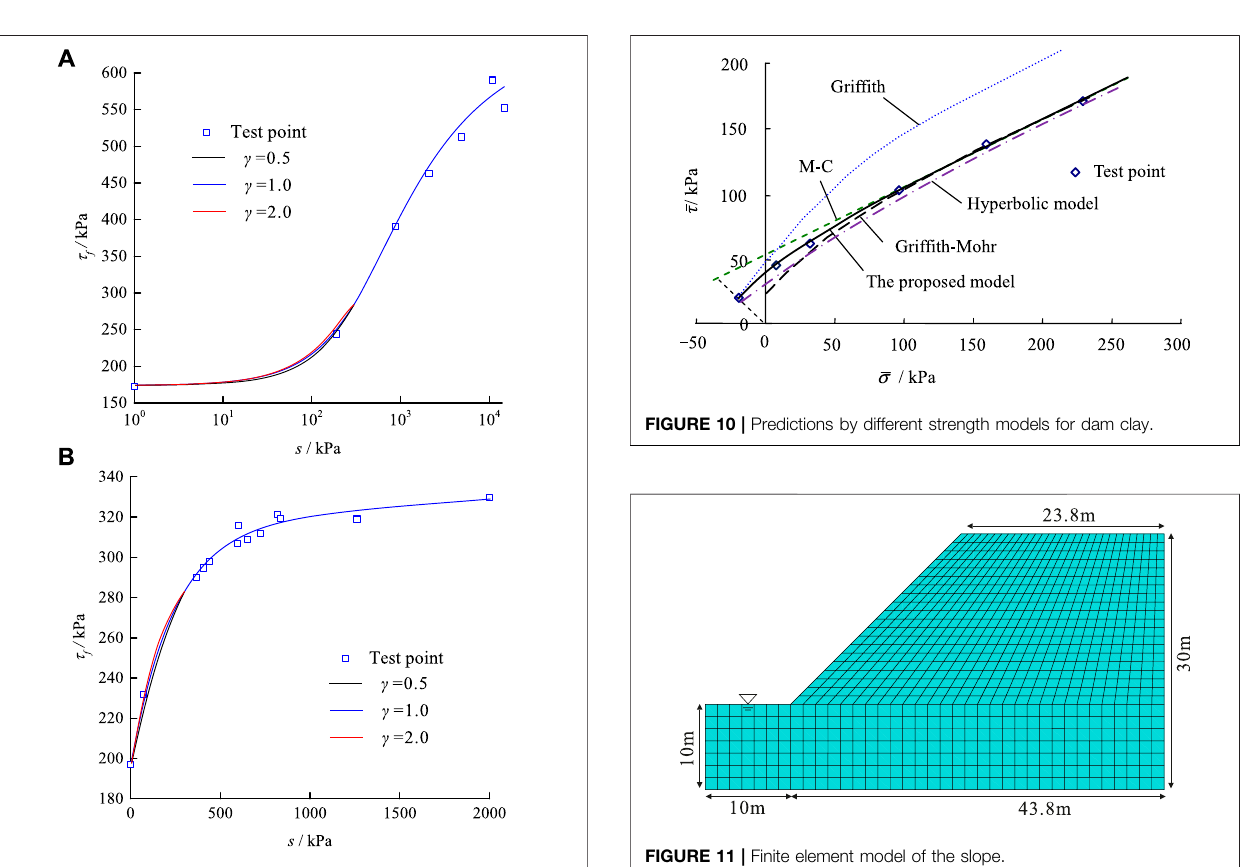
FIGURE 8 | The predictions of the compression-shear strength model: (A) Madrid clay and (B) kaolin clay.